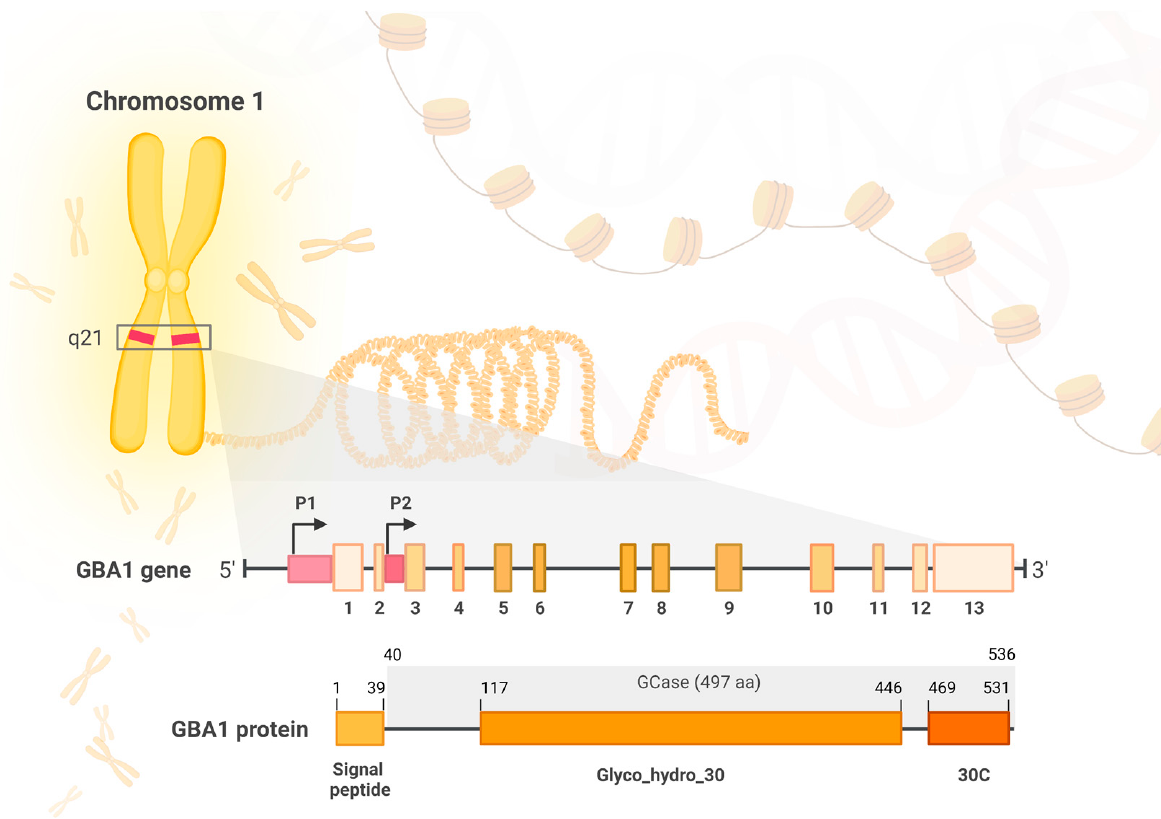
Figure 1. The structure of the GBA1 gene and the encoded GBA1 protein ( β -glucocerebrosidase/GCase). GBA1 gene, located at q21 region of chromosome 1, comprises 13 exons and 2 promoters (P1 and P2), and is characterized by multiple splicing variants and transcription start sites. GBA1 protein is composed of three main regions: 39-residue signal peptide, the conserved catalytic domain Glyco_hydro_30 (329 aa) and Glyco_hydro_30C domain (30C in the picture; 62 aa). The mature GBA1 protein—GCase—is composed of 497 amino acids (residues 40–536) and it includes Glyco_hydro_30 and 30C regions.